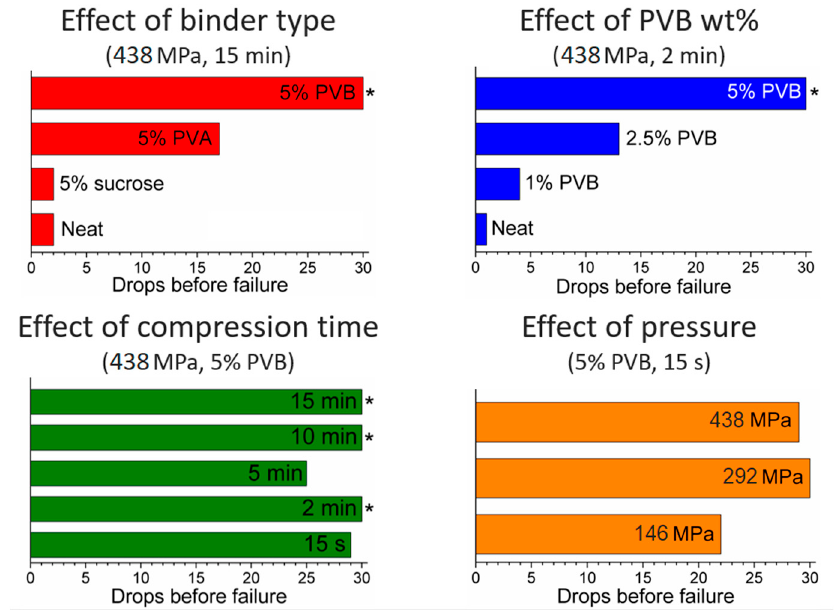
Figure 6. Results of drop tests: effect of binder type (top left), effect of binder amount (top right), effect of compression time (bottom left) and effect of pressure (bottom right). The symbol * means that no failure occurred.